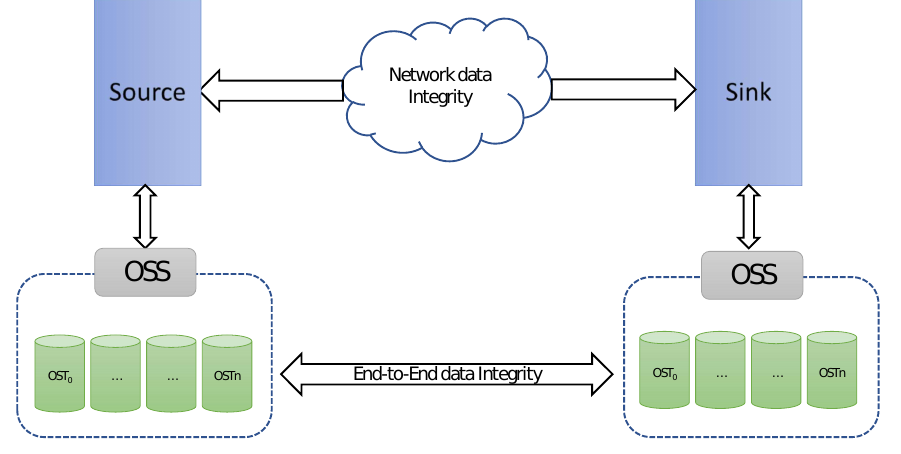
Figure 2. End-to-end data